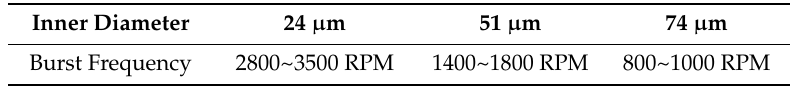
Table 1. Burst frequency of capillary tubes with di ff erent inner diameters for ionic liquid (IL).